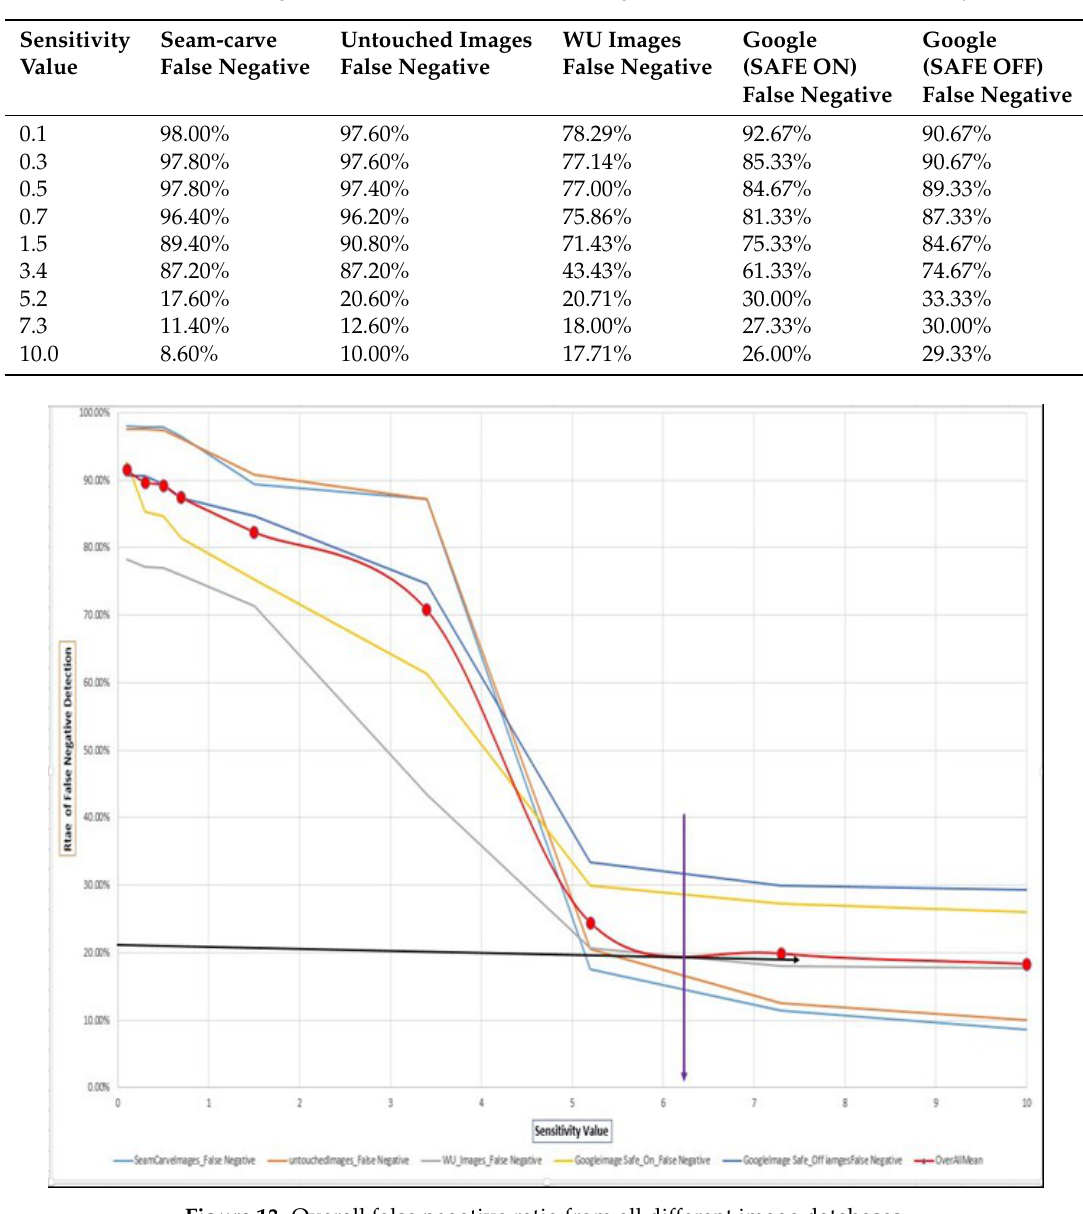
Figure 13. Overall false negative ratio from all different image